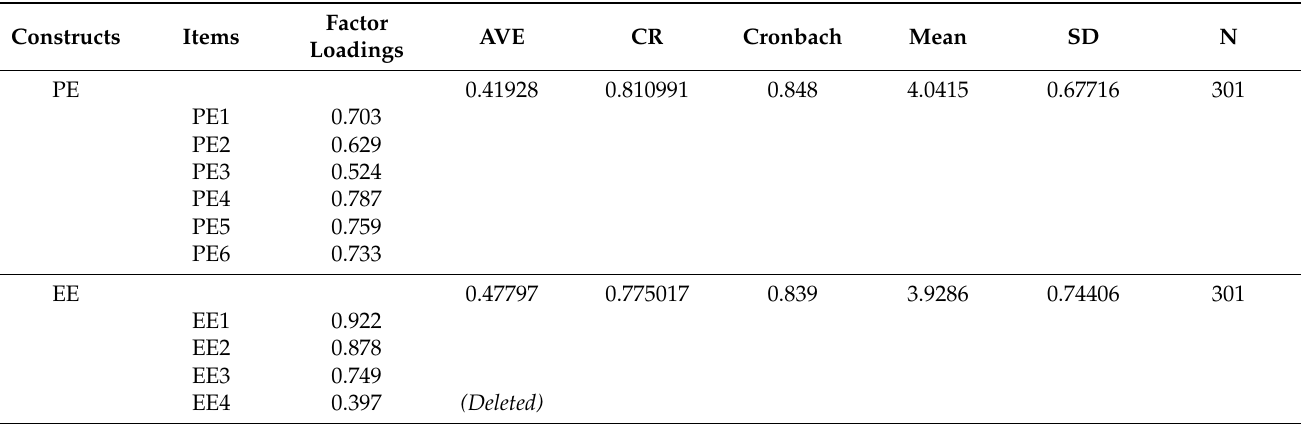
Table 3. Results of reliability and convergent validity